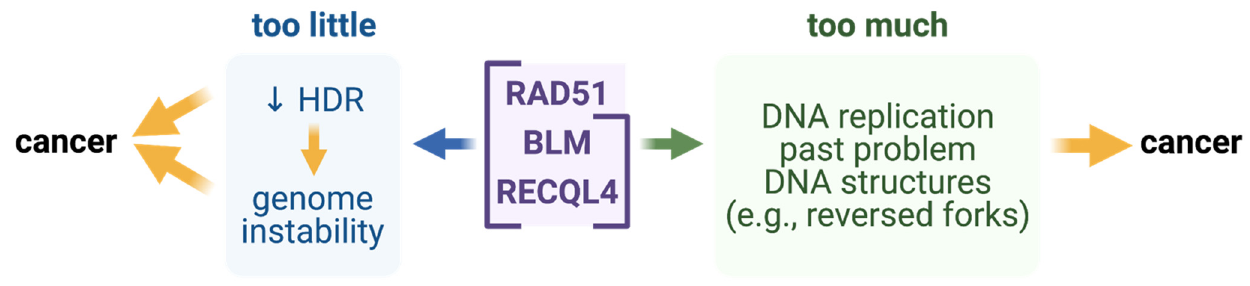
Figure 2. Hypothesis: Proteins that promote or prevent reversed replication forks needed at “Goldilocks” levels for cancer avoidance. Findings on—(1) the promotion of reversed forks in cells by E. coli RecA (RAD51 ortholog) overproduction, and their prevention by RecQ [18]; and (2) the strong correlations in cancers of RecQ-orthologous BLM and RECQL4 mRNA levels with RAD51 mRNAs [18]—suggest that “too much” BLM or RECQL4 proteins might allow DNA replication by averting replication-fork reversal, promoted by RAD51 overproduction, which is seen in many cancers [18]. “Too little” RAD51, BLM, or RECQL4 is cancer-driving due to various mechanisms that instigate genome instability, which drives cancer evolution [35].